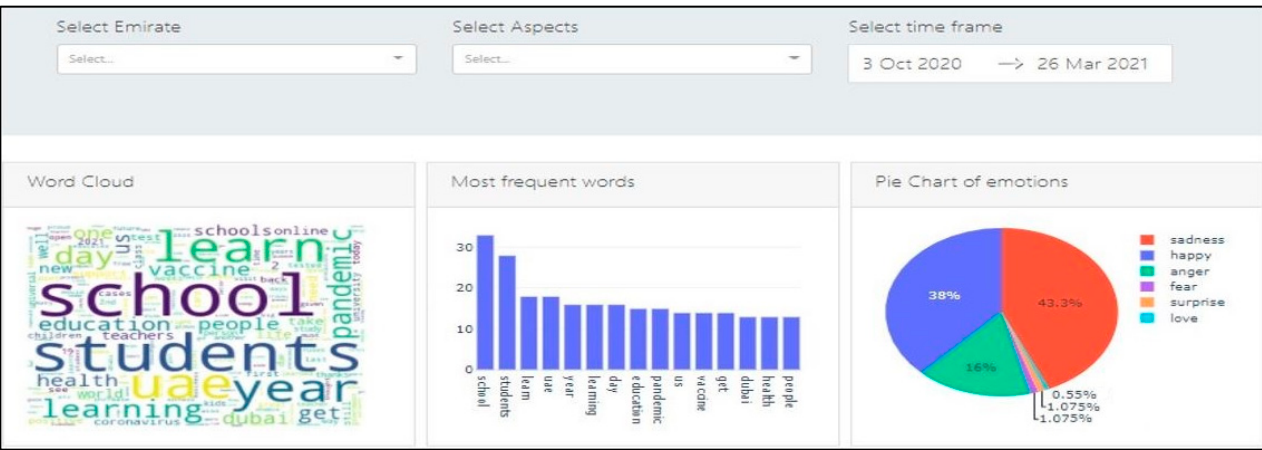
Figure 11. Testing Scenario#1.